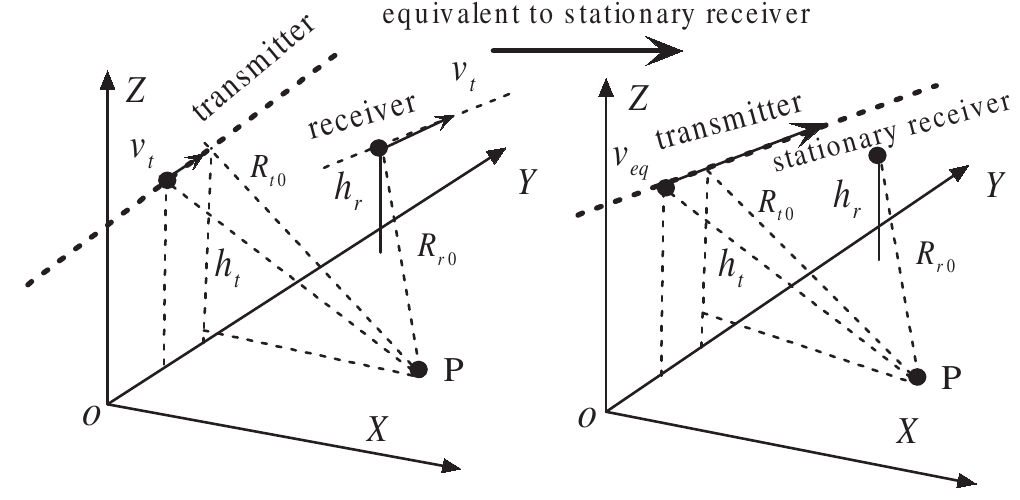
Figure 5. Azimuth-variant BiSAR geometry and its equivalent model with stationary